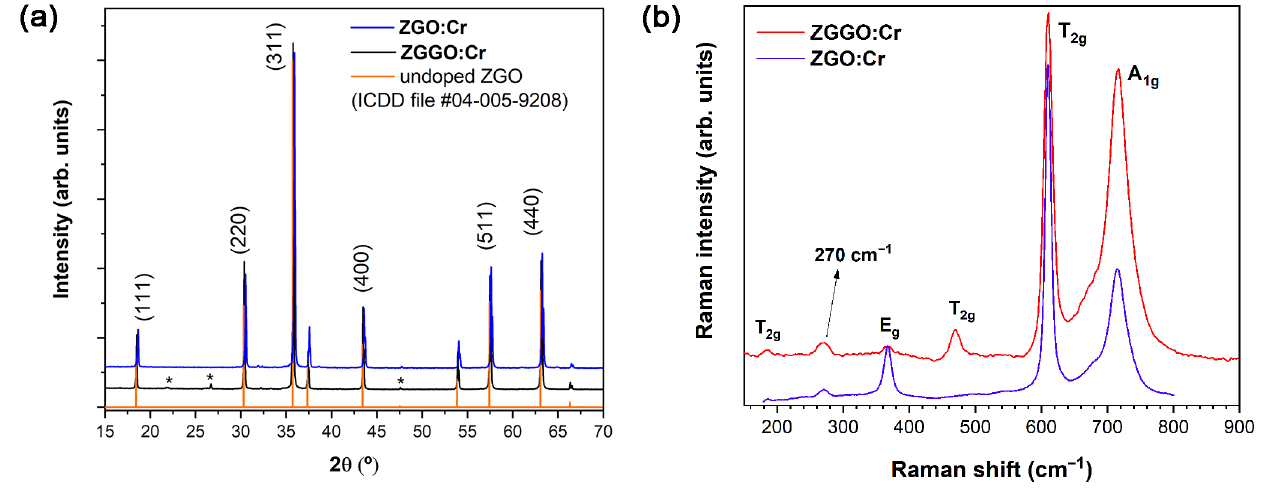
Figure 2. ( a ) X-ray diffractograms of ZGGO:Cr, ZGO:Cr, and ZGO (ICDD file #04-005-9208) with the assigned (hkl) diffracting planes of the cubic spinel structure. The * correspond to diffraction maxima due to SiO 2 contamination. ( b ) Raman spectra of the ZGGO:Cr and ZGO:Cr pellet